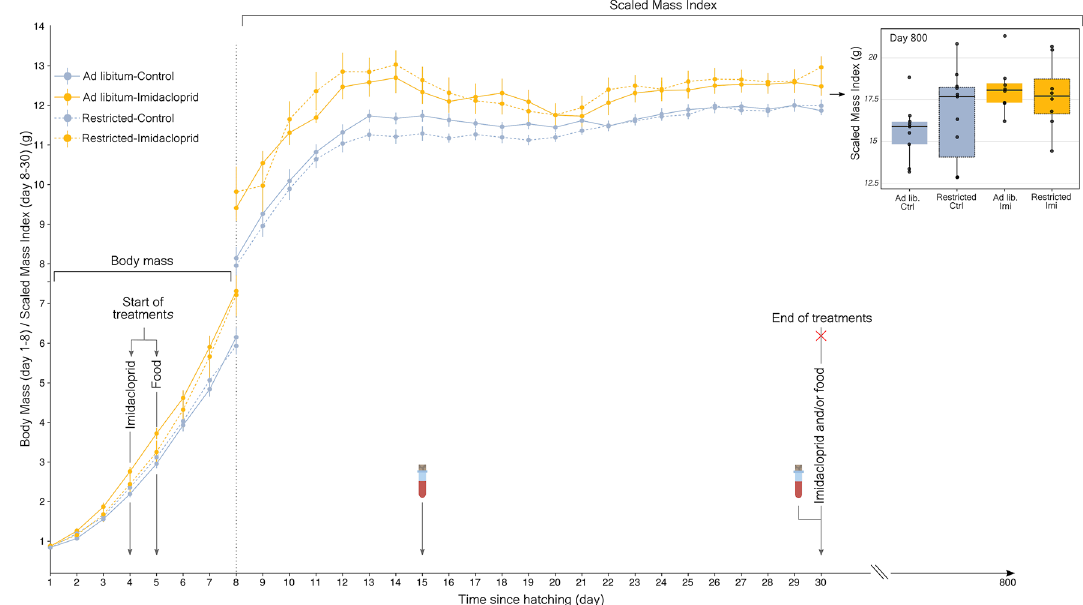
Figure 1. Mean daily body mass (s.e.m.) according to the four treatments (Day 1–30) in the first half of the experiment. Daily administration of imidacloprid (0.205 mg kg body mass − 30 after hatching. Food treatment began on day 5. Blood samples were taken on days 15 and 30 ( Ad libitum - Control n = 18, Ad libitum -Imidacloprid n = 13, Restricted-Control n = 19, Restricted-Imidacloprid n =